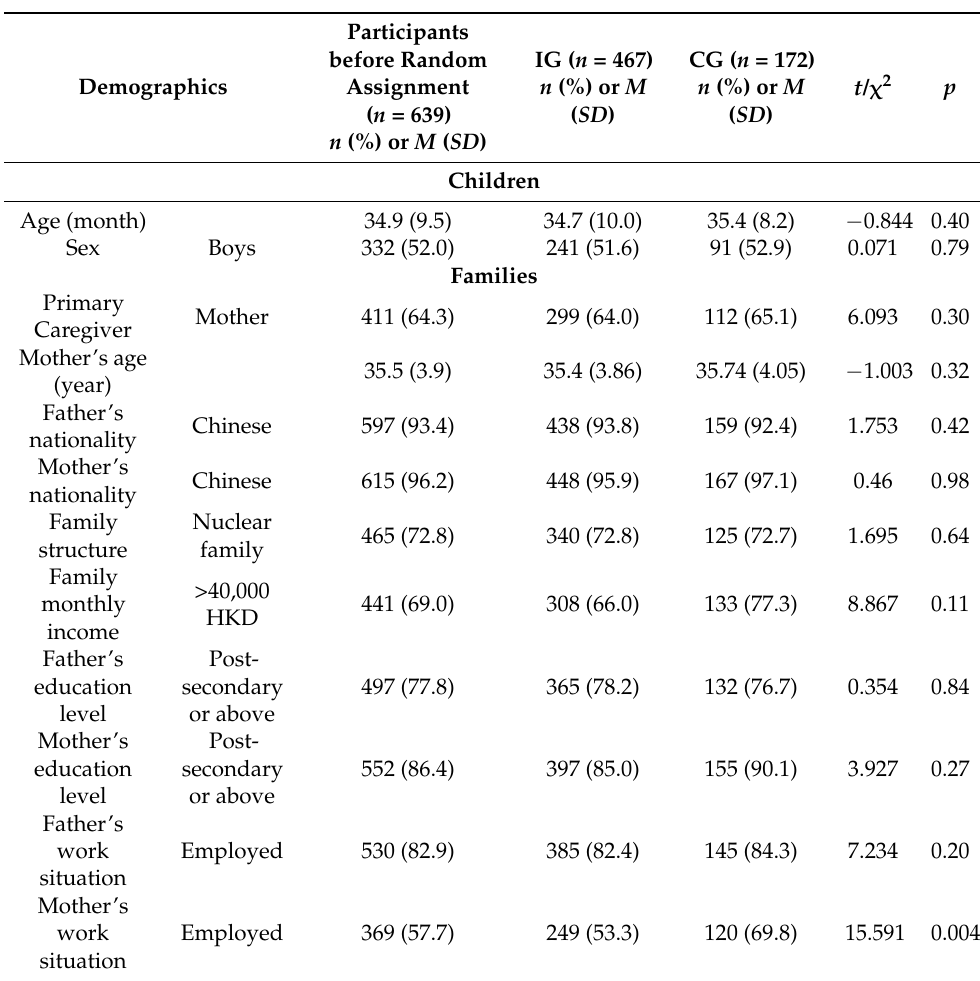
Table 4. Demographic characteristics of the participants in both Intervention (IG) and Control (CG) groups. Survey